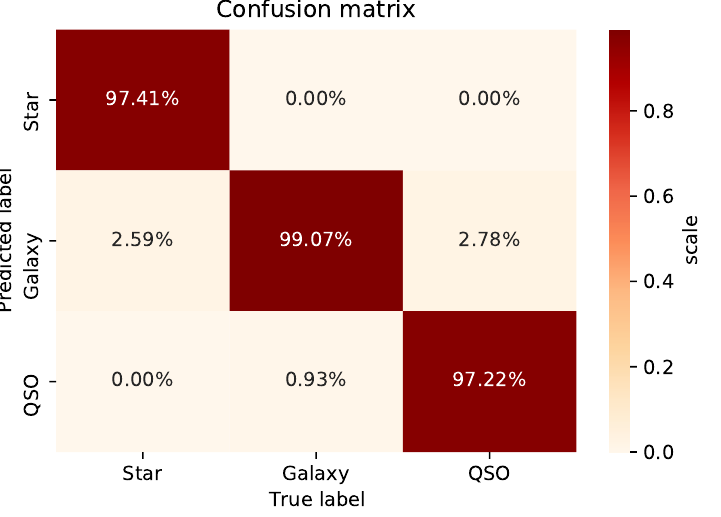
Figure 10. Confusion matrix of the classification model: percentage of accuracy for each of the classes in the test